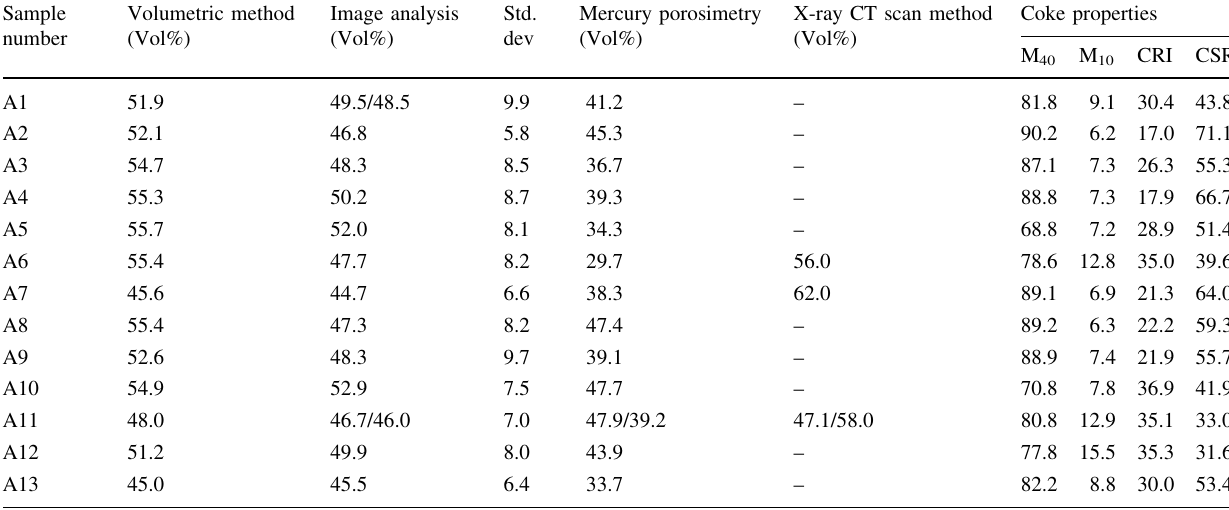
Table 5 Comparison of porosity values determined by different methods and properties of coke samples Sample number